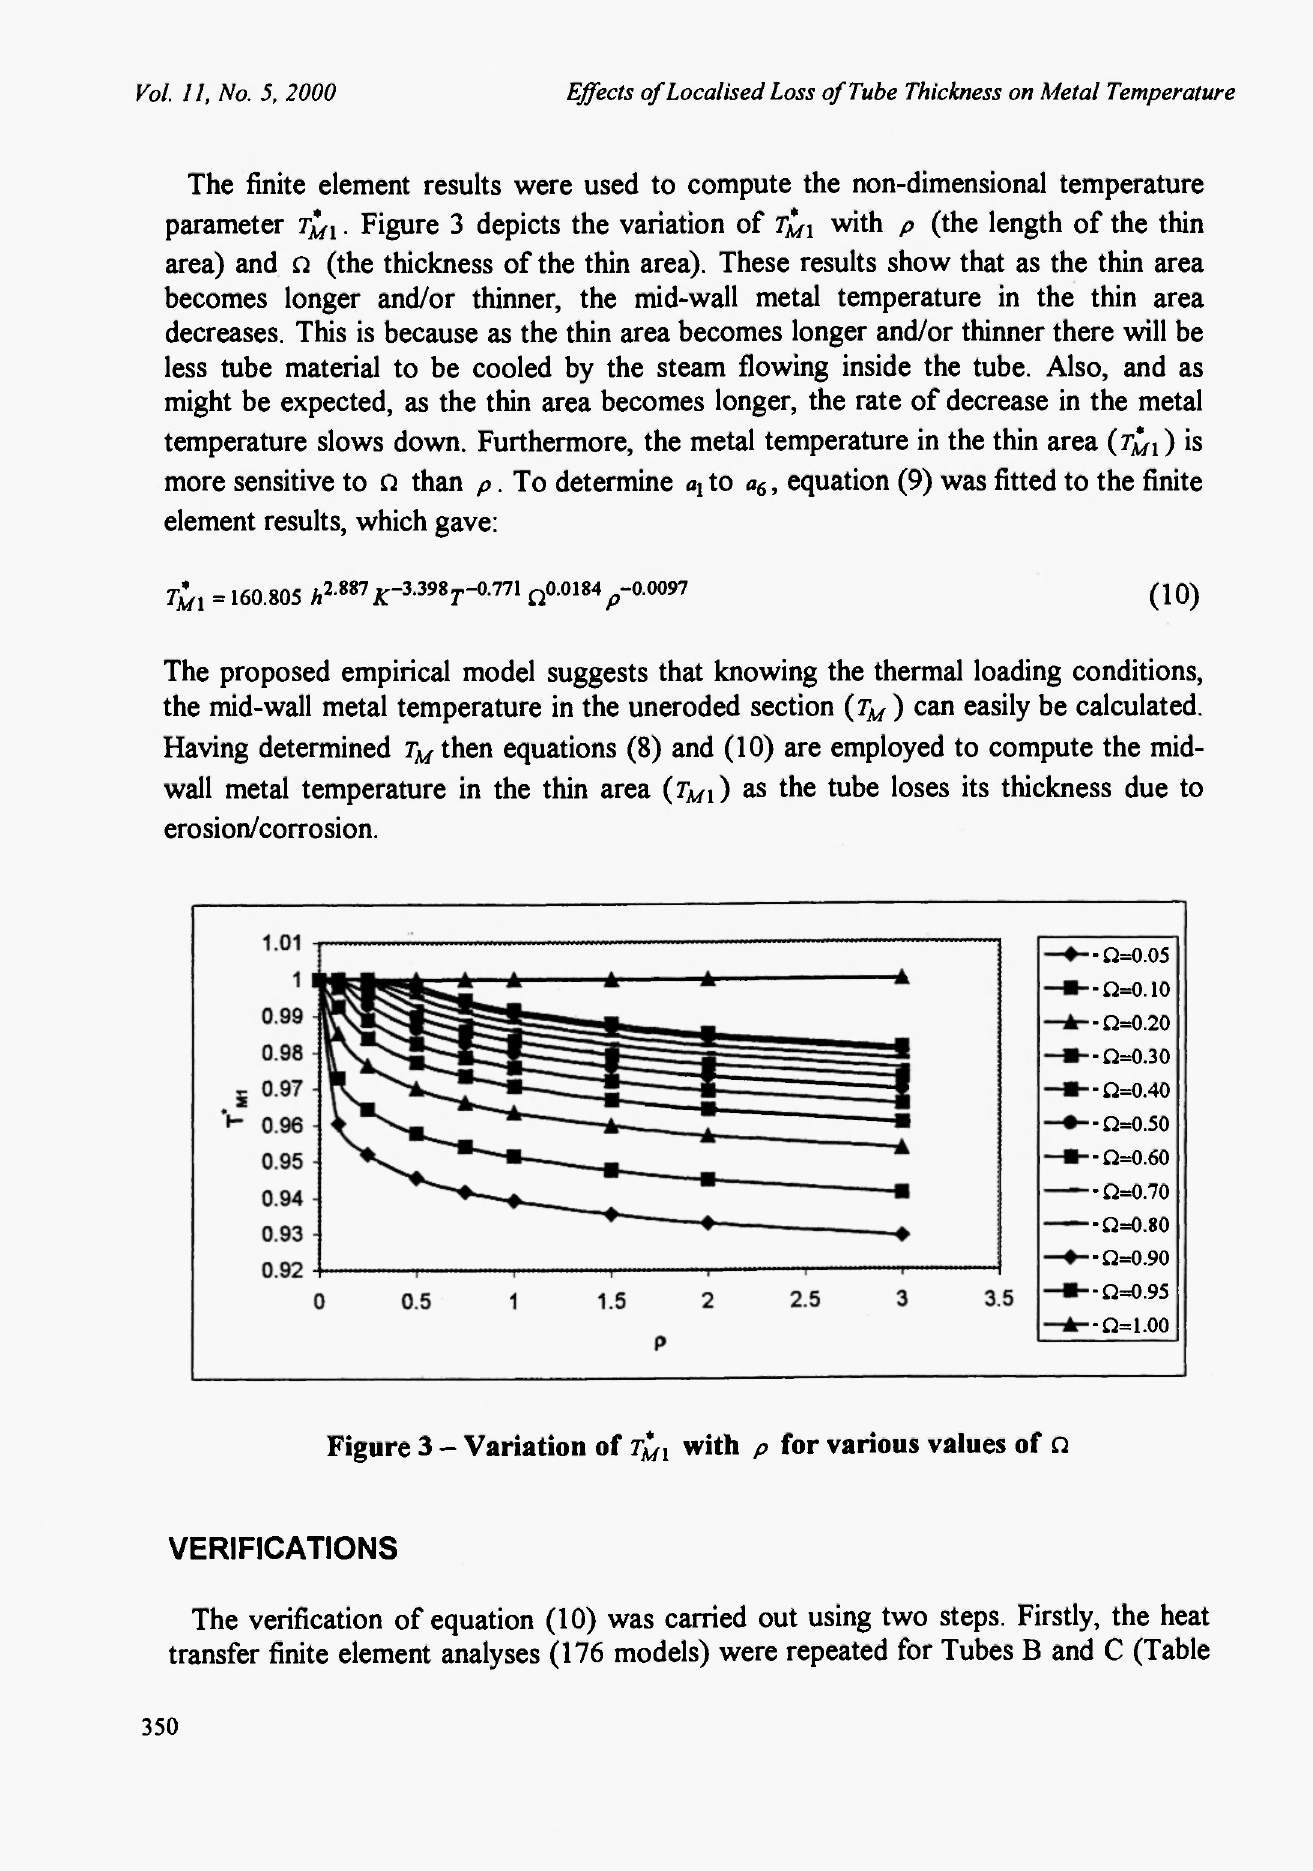
Figure 3 - Variation of τ^ with ρ for various values of